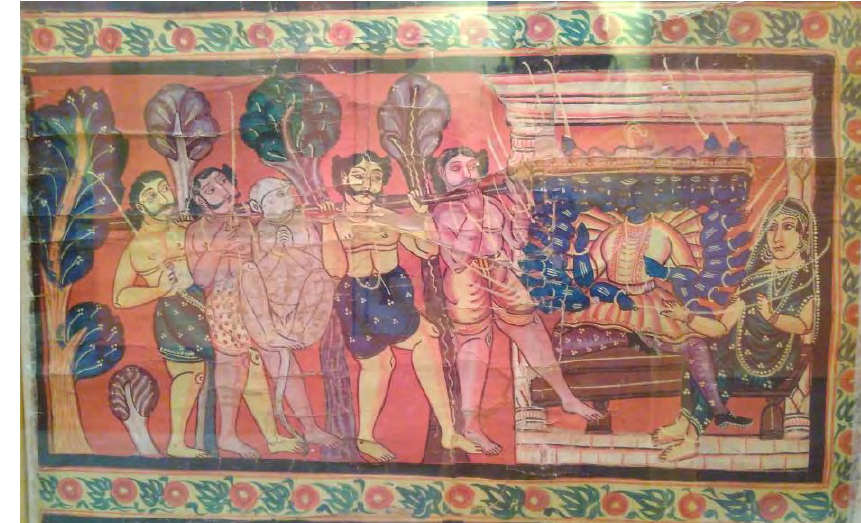
Figure 2, Close up of the Ramayana pata, National Museum, New